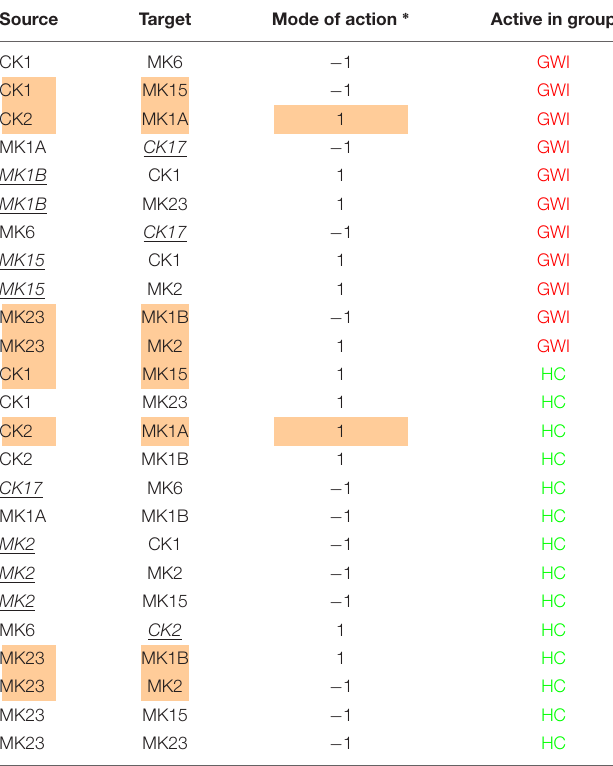
TABLE 5 | Documented immune signals represented in experimental